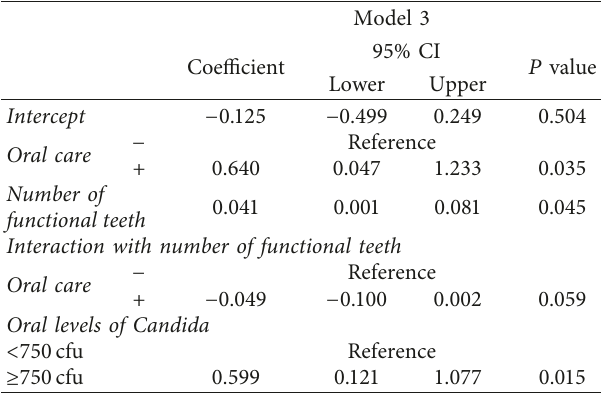
Table 3: Effect of oral levels of Candida on fever, adjusted by oral care and number of functional teeth.